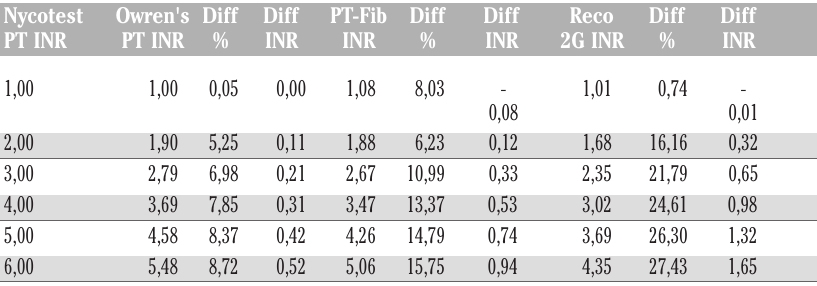
Table 1. Differences in INR results between four PT methods at variable INR levels as INR units and percentages. The correlation equations between methods were used for the